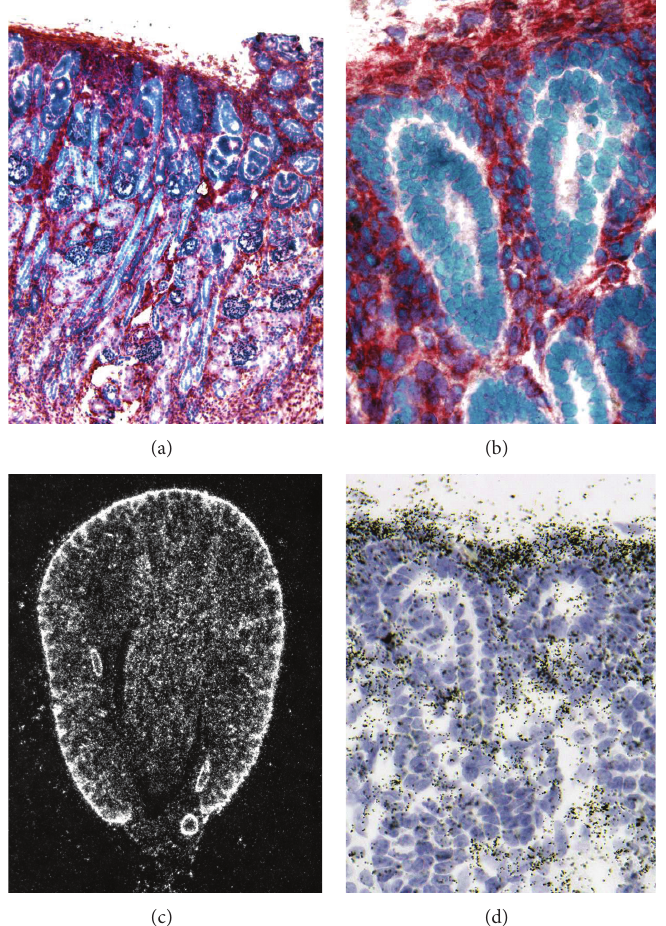
Figure 1: Mesenchymal expression of prostacyclin synthase in the developing human (24 weeks of gestation) and murine (postnatal day 0) kidney. (a) shows a low power view of a developing human kidney. (b) High power reveals absence of PGIS in epithelial structures. (c) Low power shows high subcapsular expression of PGIS-mRNA. (d) confirms the absence of labeling over epithelial structures. Primary antibodies to characterize cellular cultures were obtained from Dako (CA, USA); secondary antibodies were from Dako and Dianova (Hamburg,